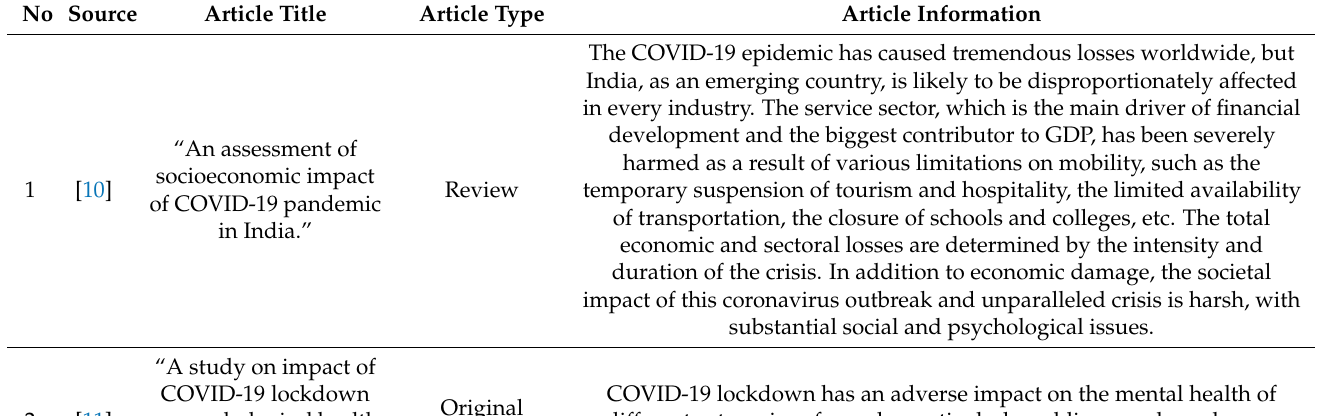
Table 2. Top 10 papers of the systematic